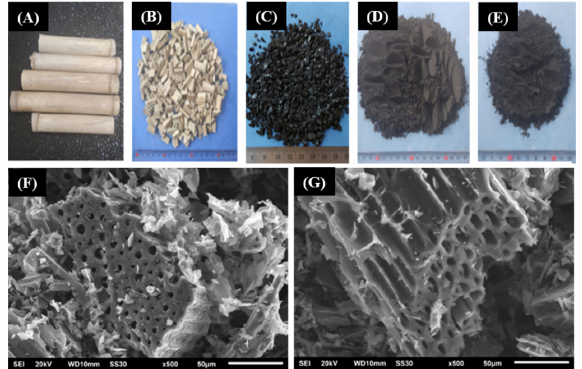
Figure 3. Illustration of formation of ACs using pyrolysis carbonization followed by chemical acti- vation (( A ) tabah bamboo; ( B ) pieces of tabah bamboo; ( C ) char; ( D ) powdered char; and ( E ) acti- vated carbon) and SEM images obtained from bamboo ( F , G ) [43] . Reprinted with permission from Surfaces and Interfaces , Copyright Elsevier 2019.